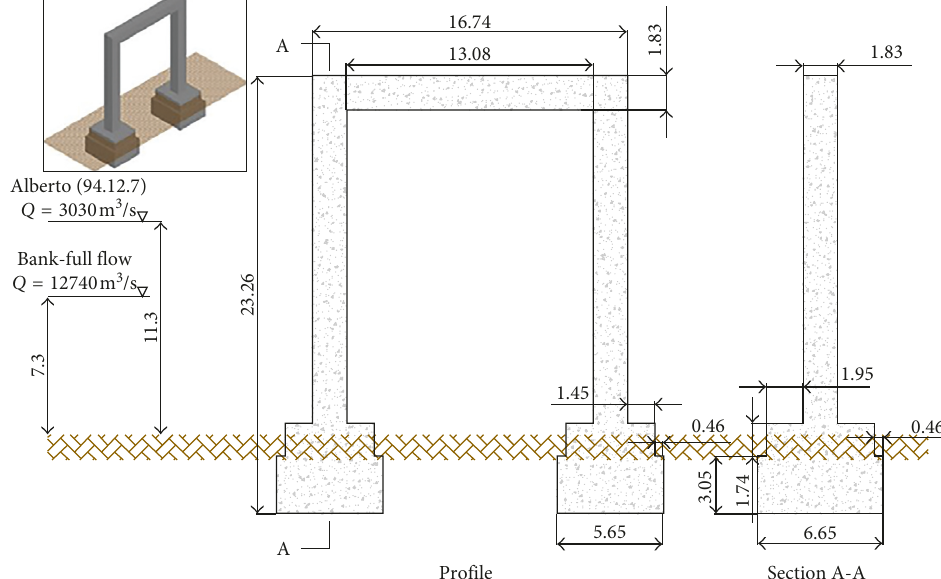
Figure 1: Dimensions of the bridge bent in Flint River at Bainbridge, GA (prototype dimensions in m).